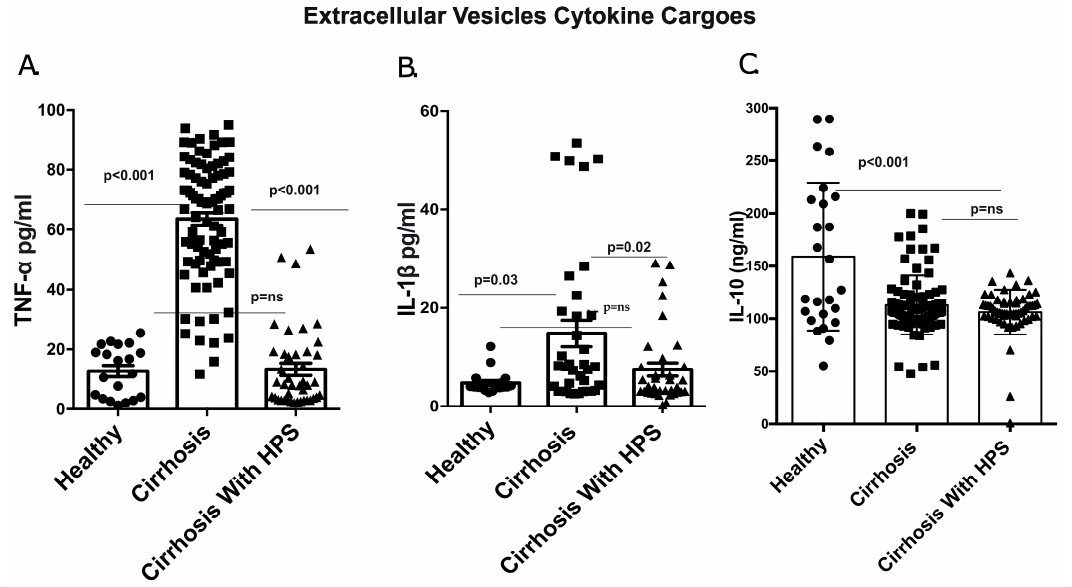
Figure 3. Extracellular vesicle cargoes. ( A ) TNF- α levels inside plasma EVs of cirrhosis patients with and without HPS and healthy controls. ( B ) IL-1 β levels in EVs of cirrhosis patients. ( C ) IL-10 levels in EVs of cirrhosis patients.